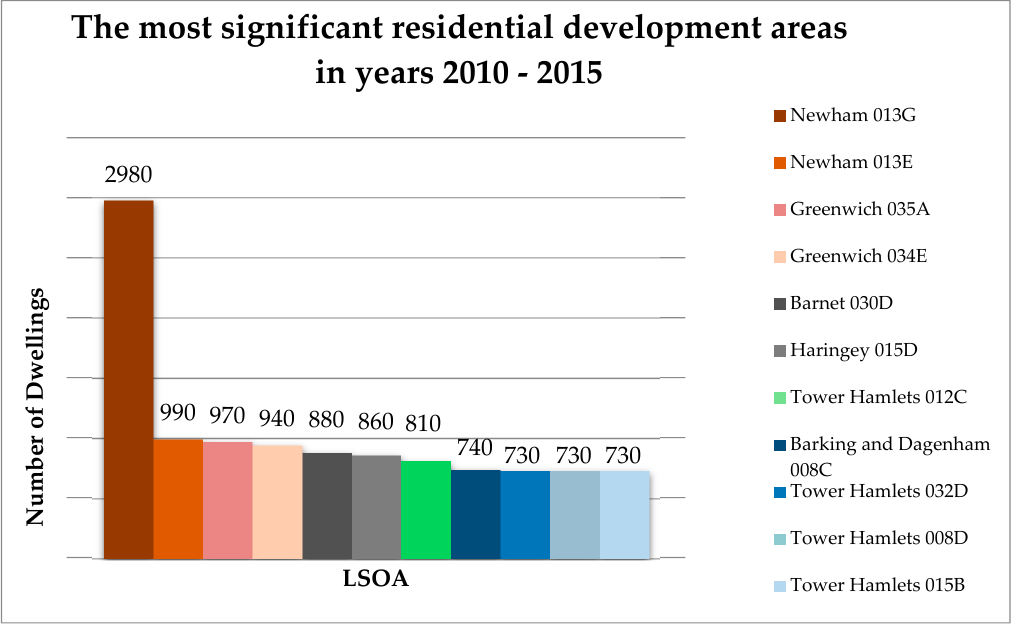
Figure 3. The 11 LSOAs with the greatest number of new residential buildings built in London between 2010 and 2015. Contains National Statistics data © Crown copyright and database right (2015) and (2012). Contains Ordnance Survey data © Crown copyright and database right (2015) and (2012).